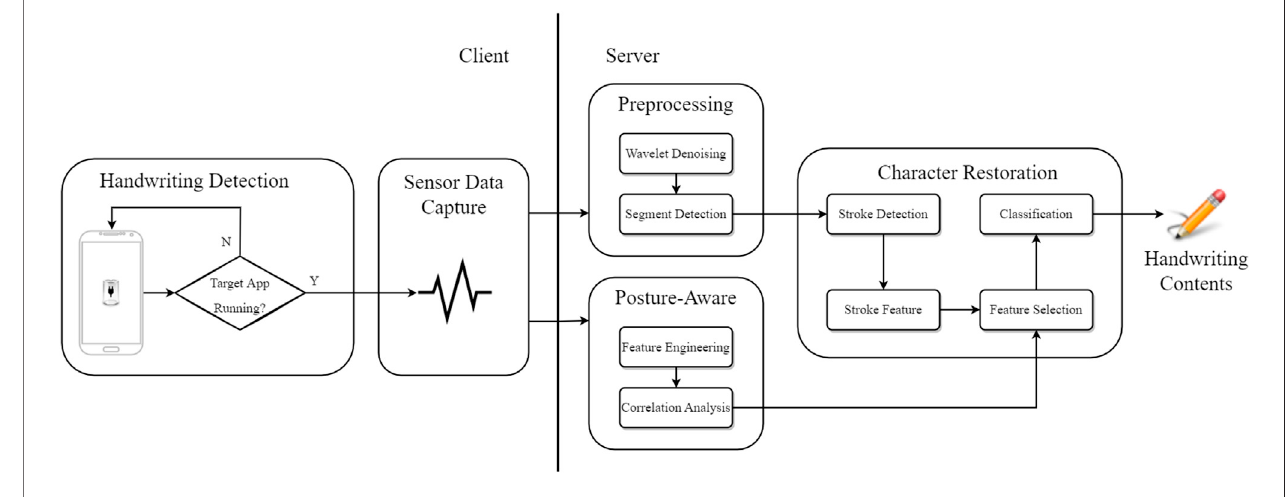
FIGURE 2 | System architecture of spider-inspired HCCapture.